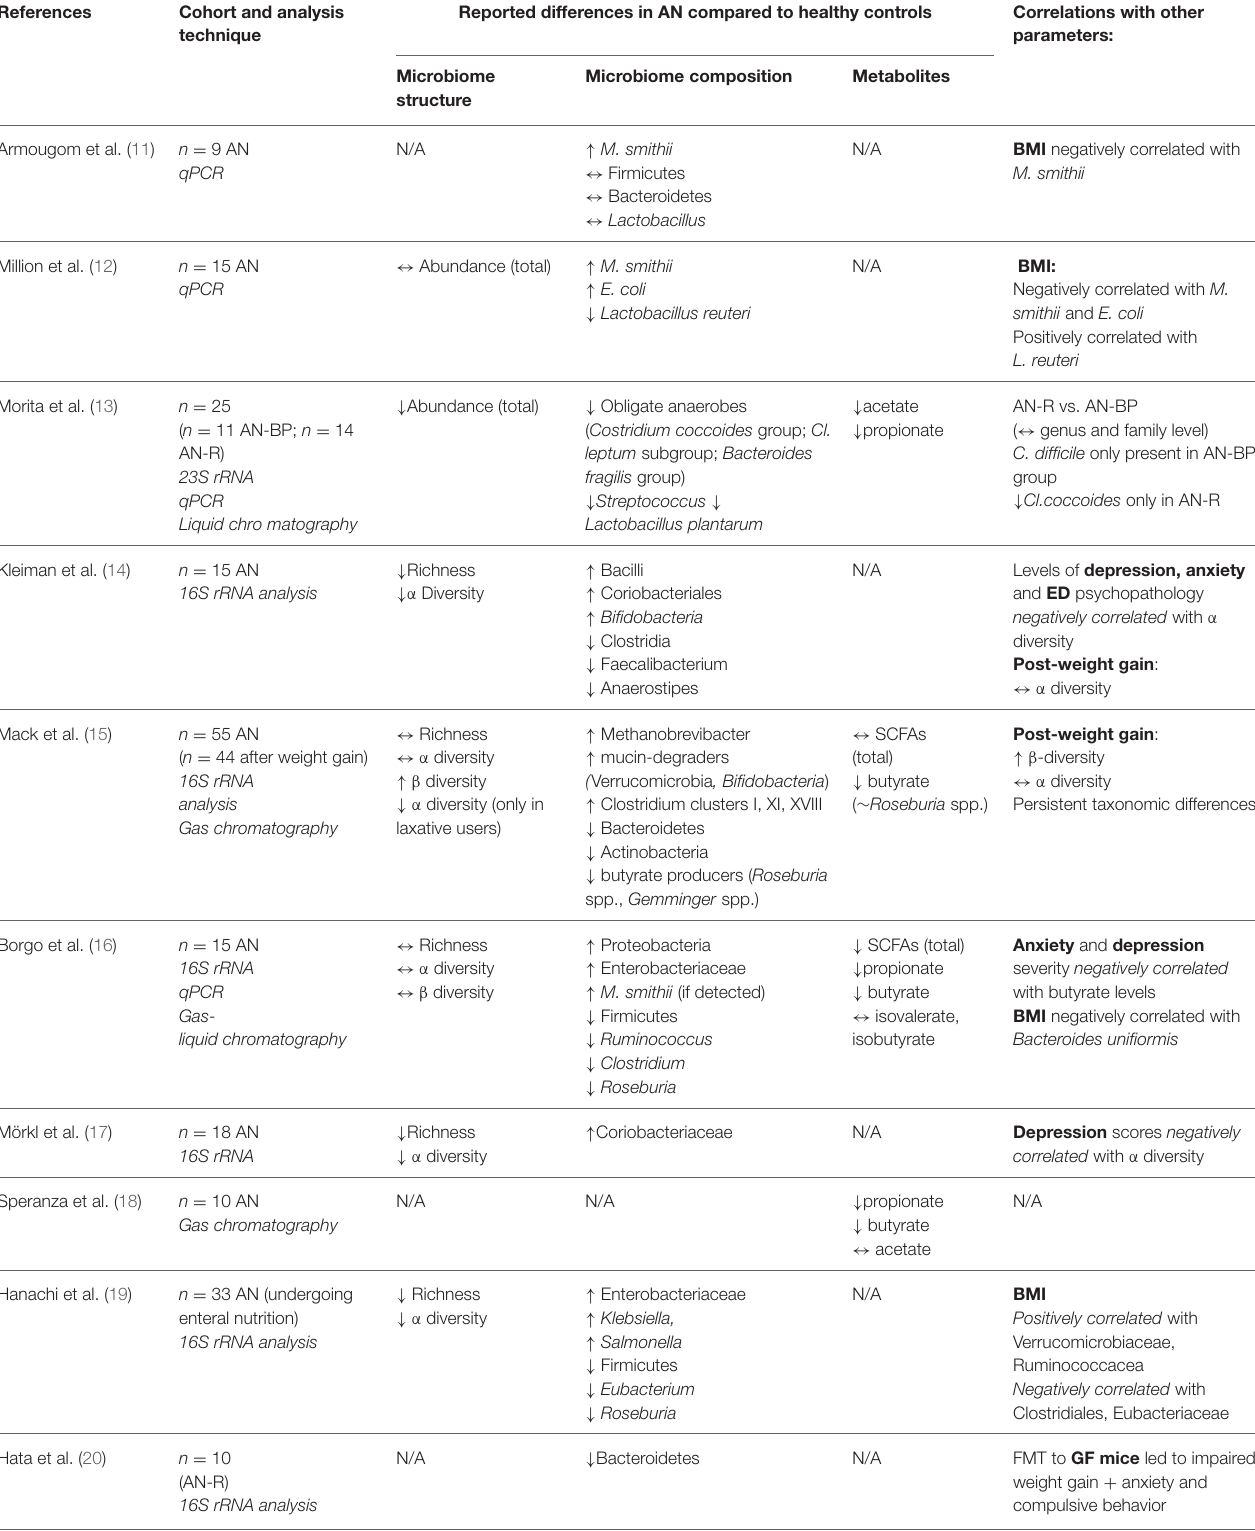
TABLE 1 | Differences in gut microbiome composition in AN